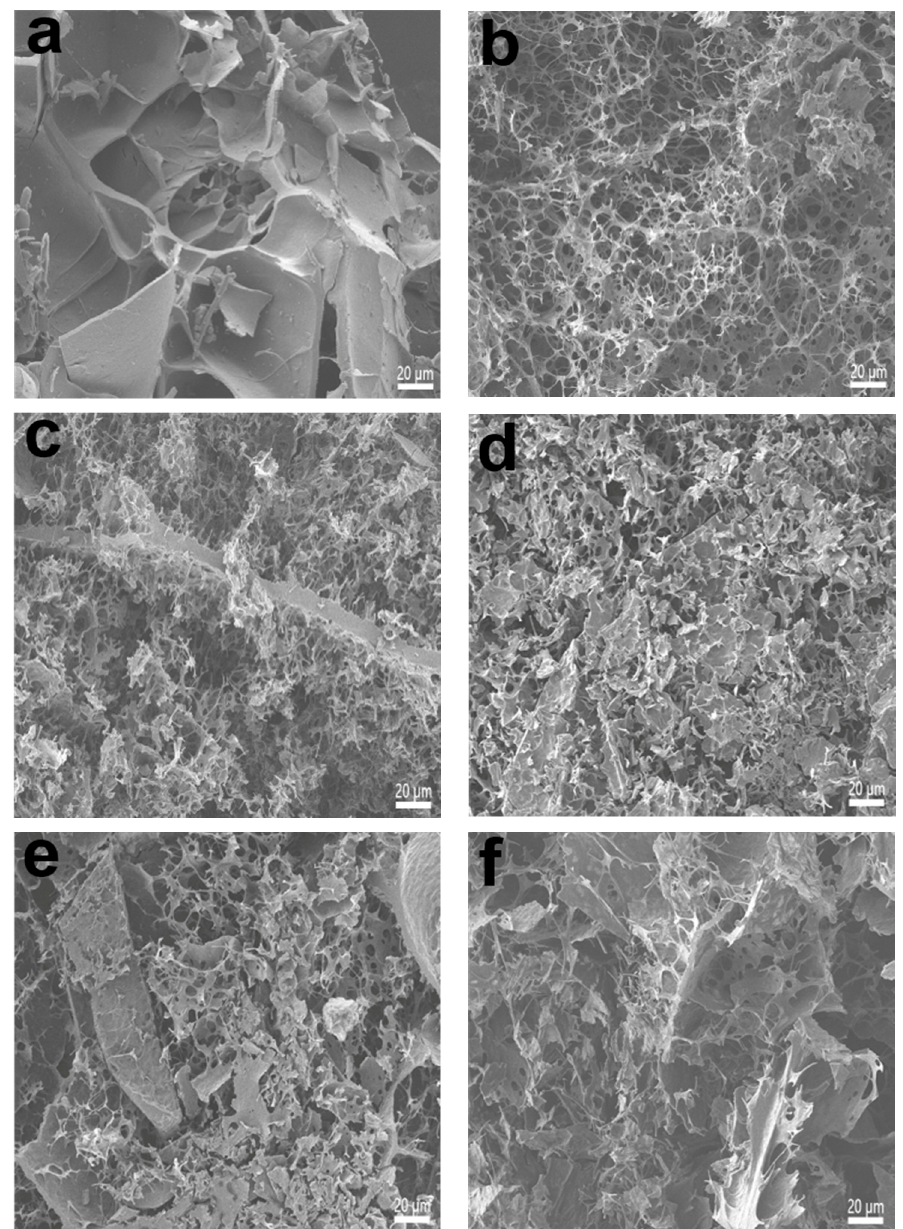
Figure 2. Scanning electron micrographs of the aerogels. Graphs ( a – f ) show the microscopic mor- phology of the EWP, EC 0 , EC 12 , EC 24 , EC 36 , and EC 48 at ×500 magnification, respectively.